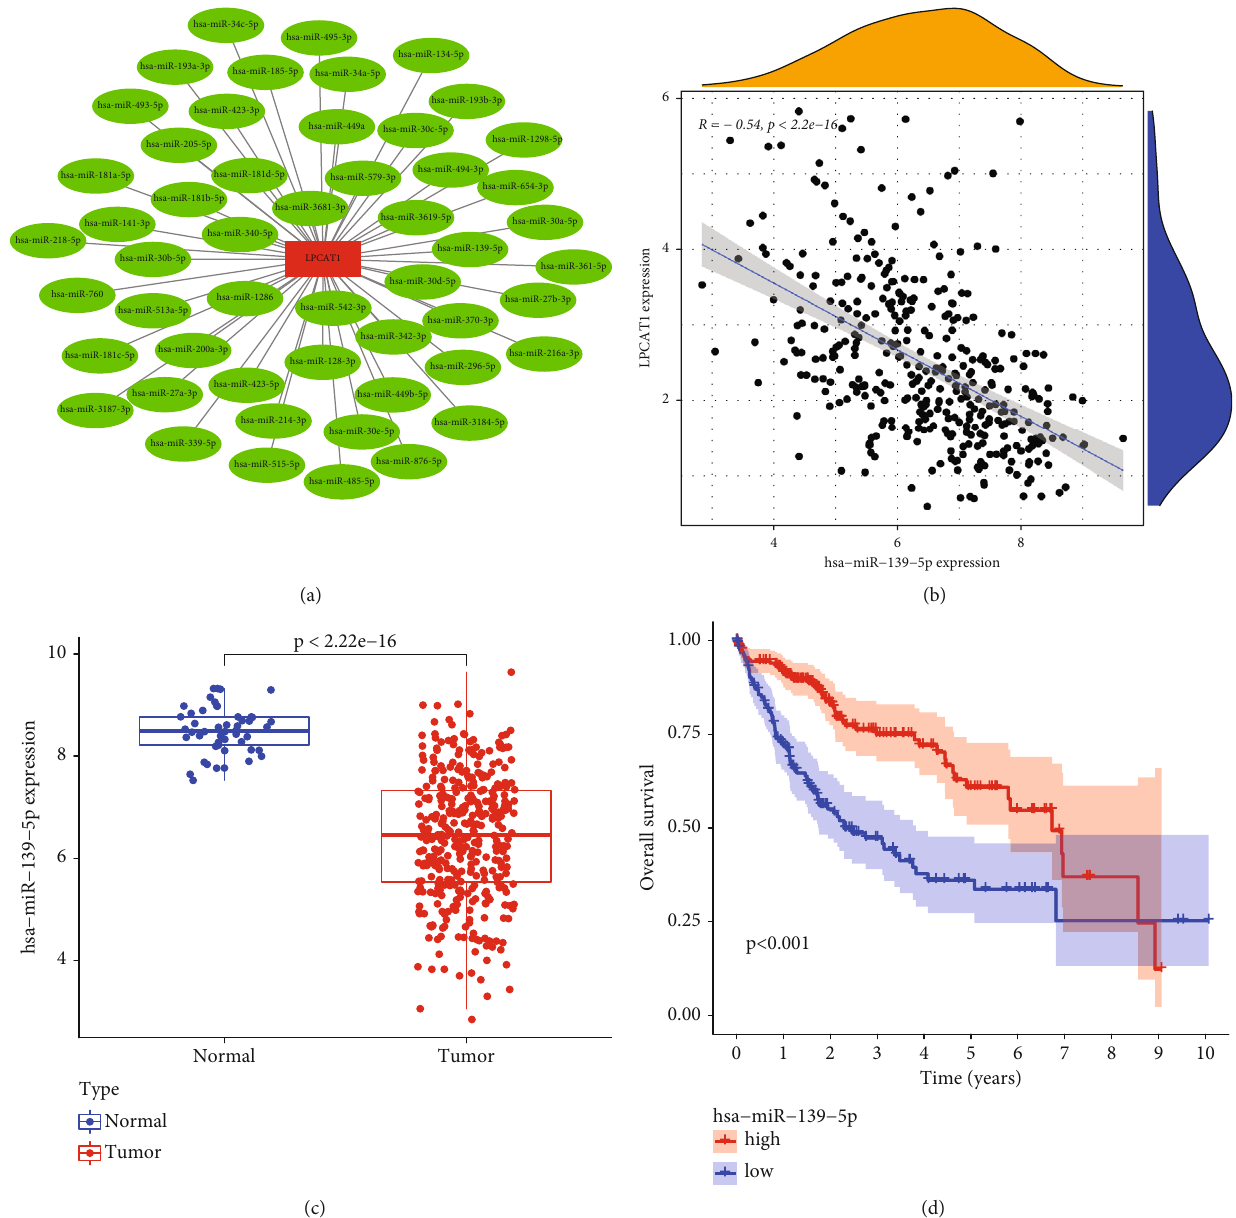
Figure 4: Identi fi cation of hsa-miR-195-5p as a potential upstream miRNA of LPCAT1 in LIHC. (a) The miRNA-LPCAT1 regulatory network established by Cytoscape software. (b) The expression correlation between hsa − miR − 139 − 5p and LPCAT1 in LIHC analyzed by R software. (c) The expression of hsa − miR − 139 − 5p in LIHC and control normal samples determined by R software. (d) The prognostic value of hsa − miR − 139 − 5p in LIHC assessed by R